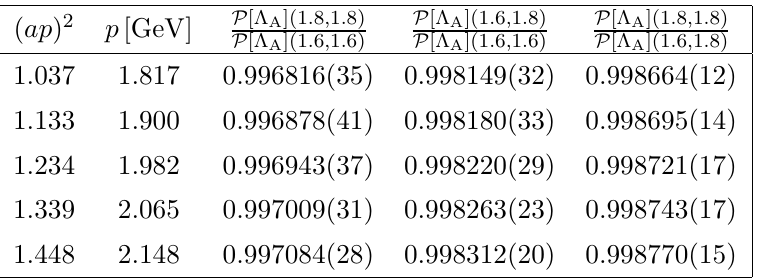
Table 5 . The ratios of projected amputated vertex function for the axial currents with di(cid:11)erent actions on the C2 ensemble. The quark mass for both (cid:12)elds is taken to be am l = 0 : 01.